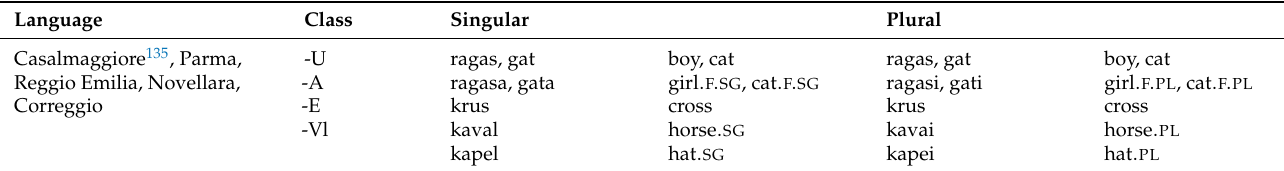
Table A4. Nouns. 134